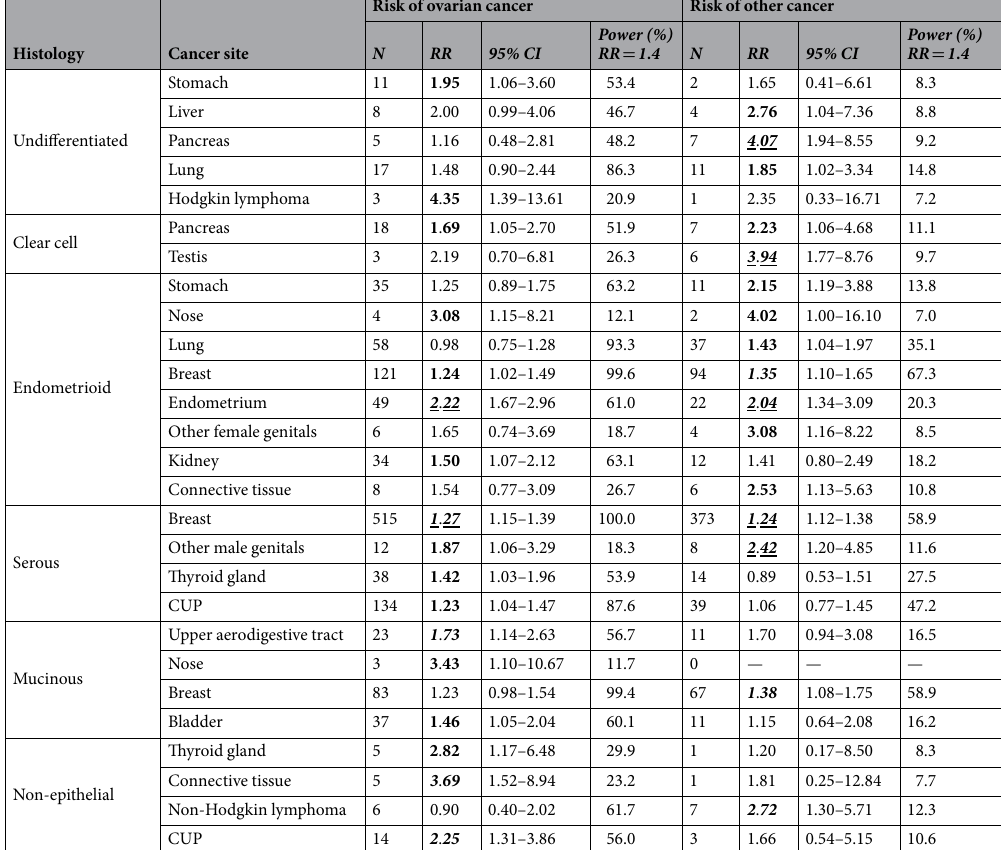
Table 4. Familial associations of histology-specific ovarian cancer with other cancers. CUP: cancer of unknown primary. Bolding, italic and underlining indicate that the 95% CI, 99% CI and 99.9% CI did not overlap with 1.00 respectively. a all cancers include ovarian cancers and all other cancers. b all cancers include all other cancers except ovarian